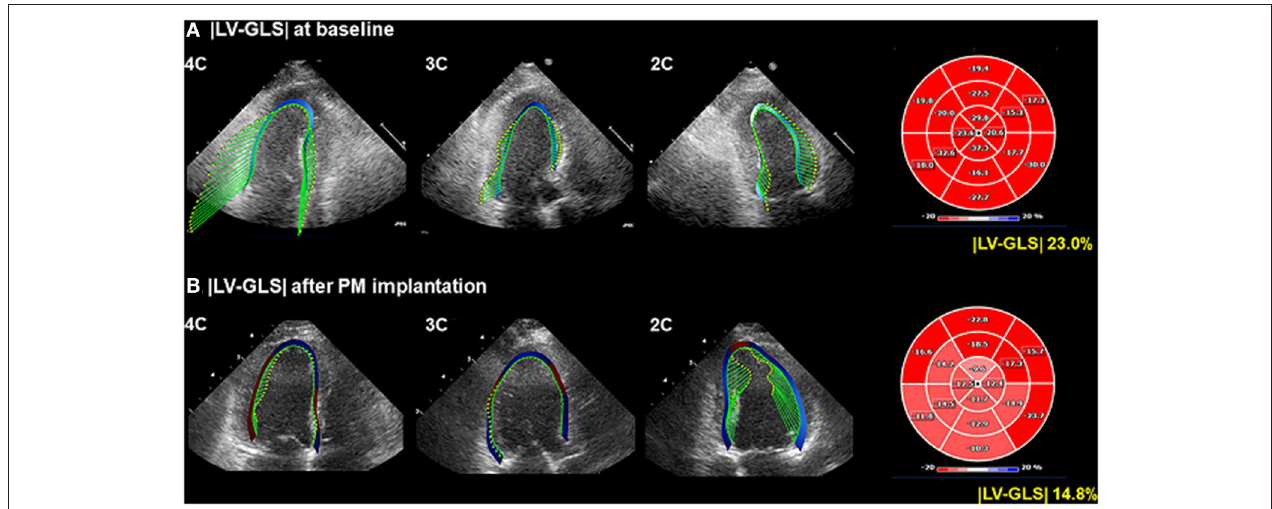
FIGURE 1 | Representative LV-GLS measurements. (A) LV-GLS was calculated from three standard apical views at baseline echocardiogram (left). The absolute value of LV-GLS was 23.0% (right). (B) LV-GLS was assessed after PM implantation. |LV-GLS| was 14.8% (right). LV-GLS, left ventricular global longitudinal strain; PM,